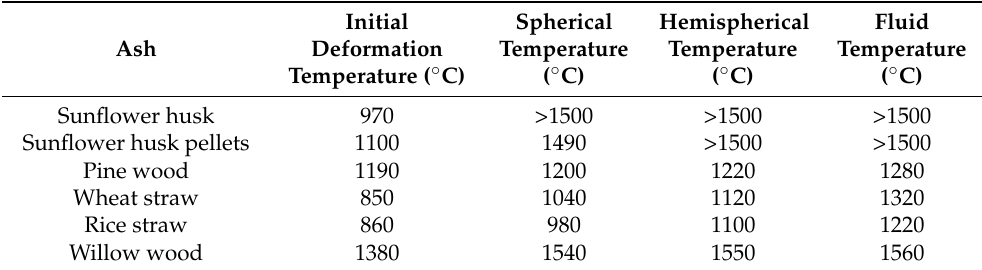
Table 4. Properties of ash from sunflower husk and sunflower husk pellets and from various types of biomass